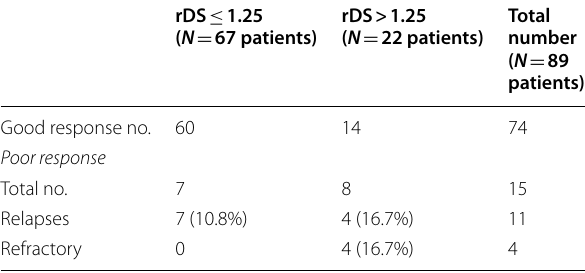
Table 9 rDS above and below the cutoff value and prognosis in extra‑nodal lymphoma